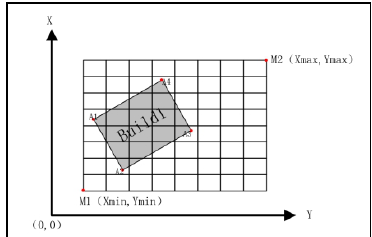
Figure 2. Schematic diagram of the relationship between vector data and raster